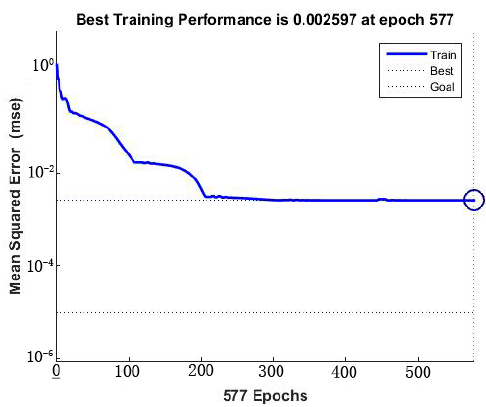
Figure 7. MSE vs. the number of epochs. Table 3. Variables importance analysis of input for the output in ANN model.